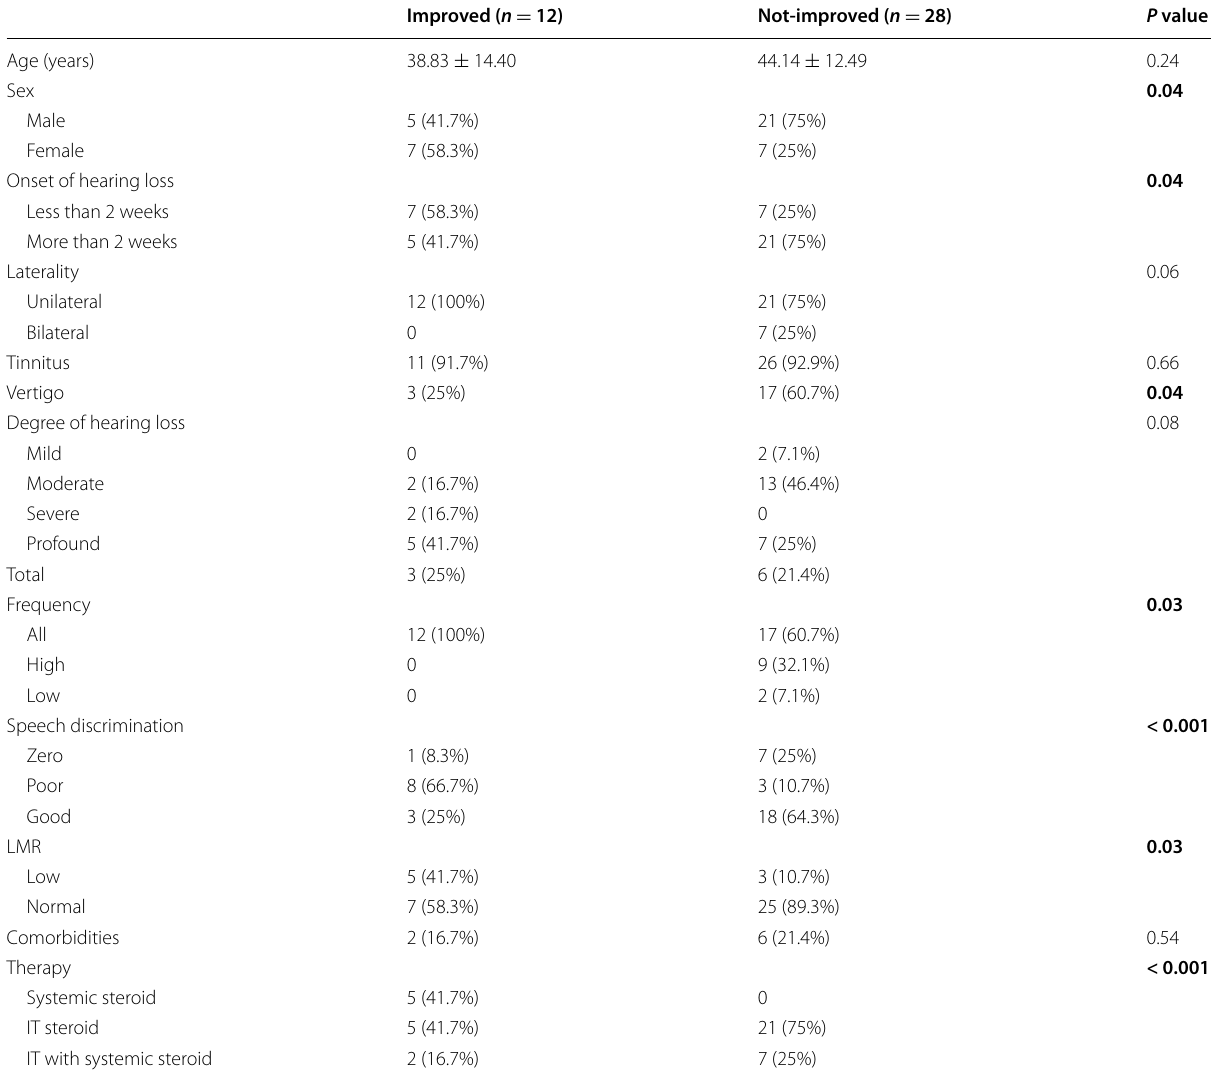
Table 3 Characteristics of patients based on the